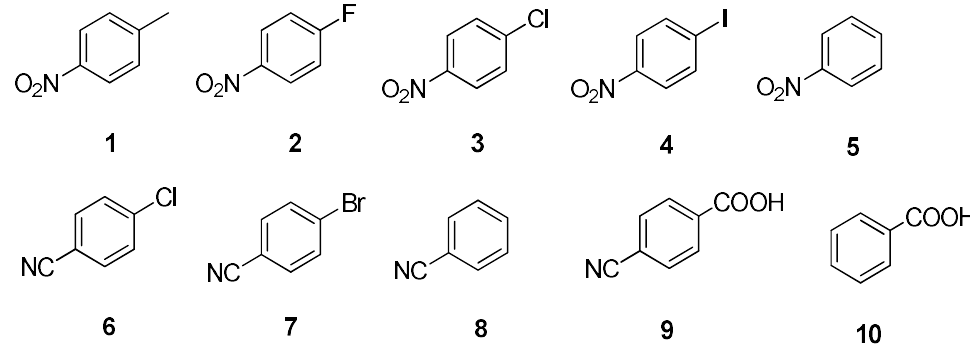
Figure 1. Structures of discussed compounds.